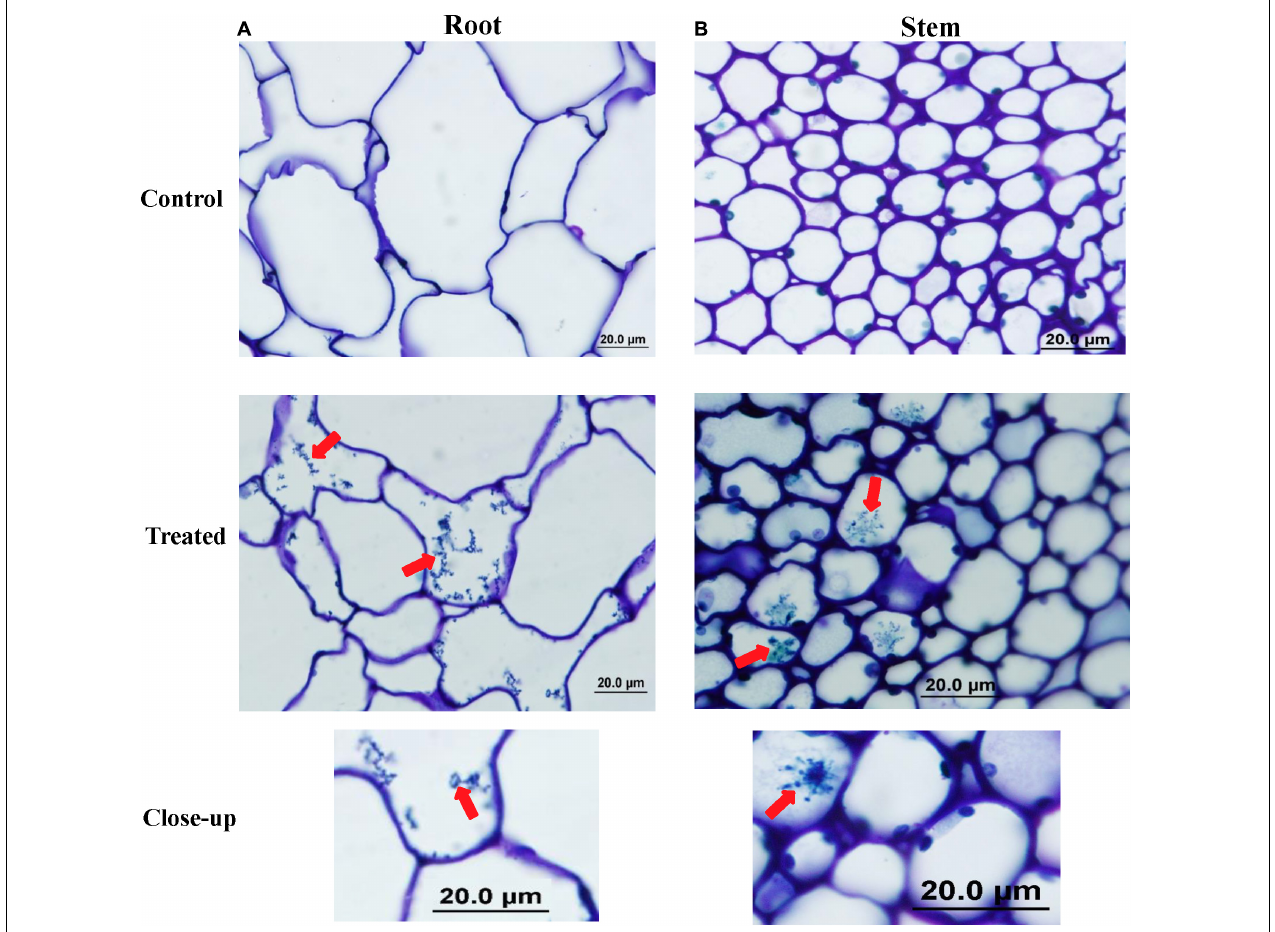
FIGURE 3 | Colonization of mangrove tissues by the endophytic isolate #24. Light micrograph of semi-thin sections of gray mangrove (A) root and (B) stem tissues not inoculated (control; top); or inoculated with isolate #24 (treated; middle); and spiral chain of spores (close-up; bottom) of isolate #24 within treated tissues (1,000 × ). In (A,B) , all sections were stained with 0.1% toluidine blue showing the distribution of mycelium and spiral chain of spores (red arrows) in root and stem tissues within mangrove cells. Isolate #24 represents the PA-producing Streptomyces mutabilis UAE1. PA, polyamine. Bars: 20 µ